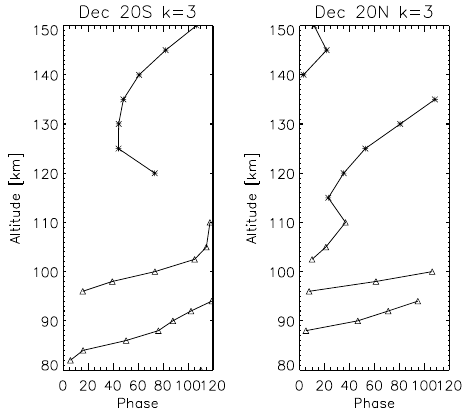
Figure 10. Phase of MIPAS average (2007–2012) | n odd − s | = 3 for December at 20 ◦ S (left) and 20 ◦ N